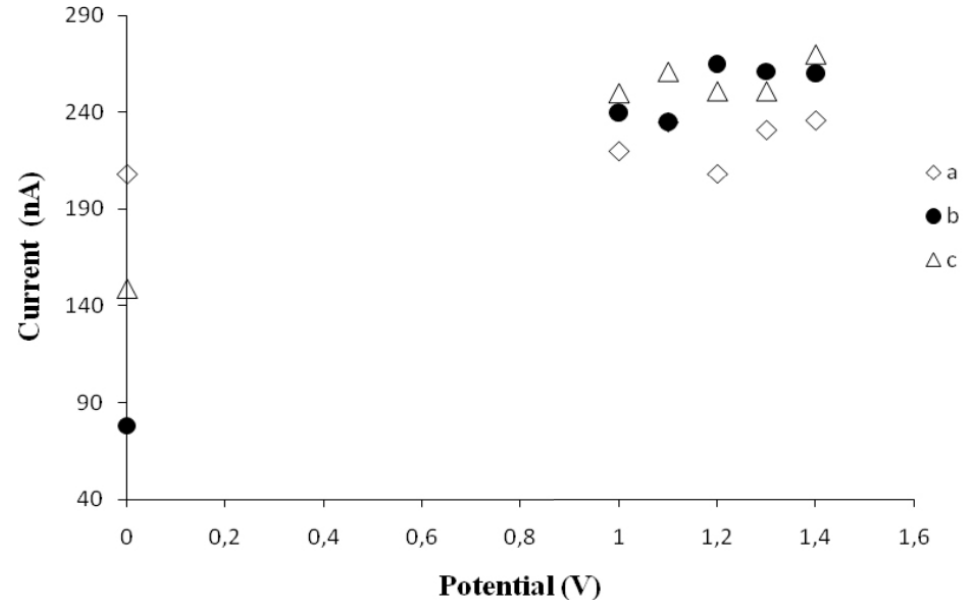
Figure 5. Effect of different potentiostatic pretreatments on the adsorption and electrooxidation of dsDNA at different electrodes: a) MWNTPE b) MWNTPE , c) MWNTPE . The pretreatments were performed in 0.20 M acetate buffer solution pH 5.00 for 20 s. The accumulation 2 3 step was performed at 0.50 V for 5 min in a 0.20 M acetate buffer solution pH 5.00 containing 140 mg L -1 dsDNA. The stripping